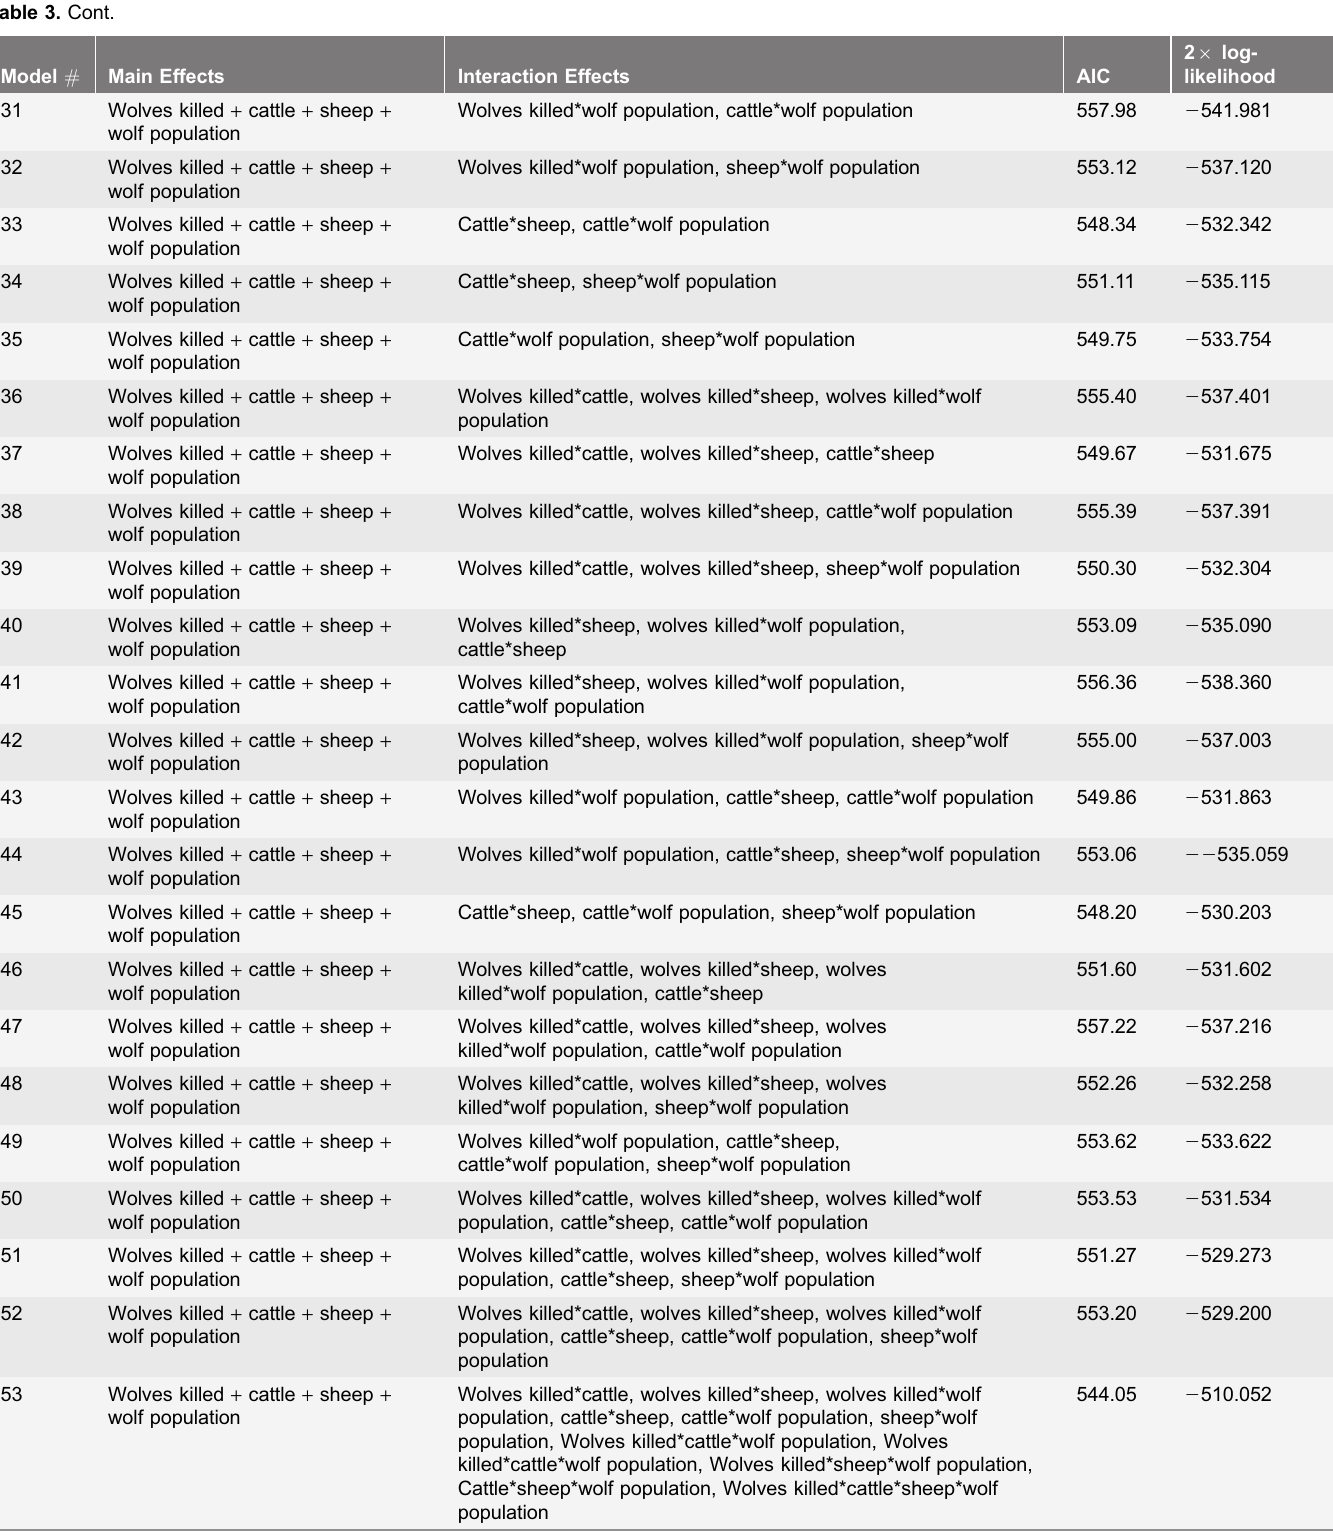
Table 3. Cont. Model